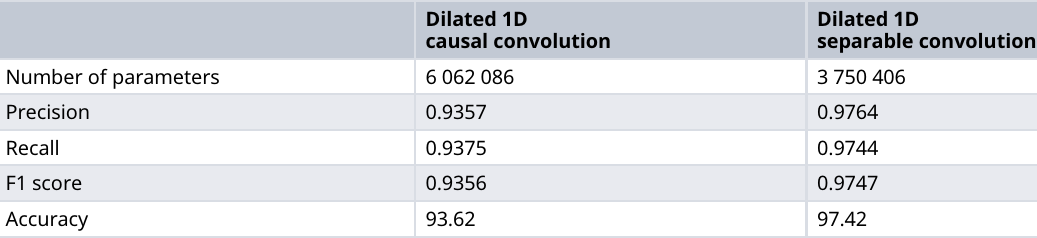
Table 3. Performance of MSTCN using different convolutions.